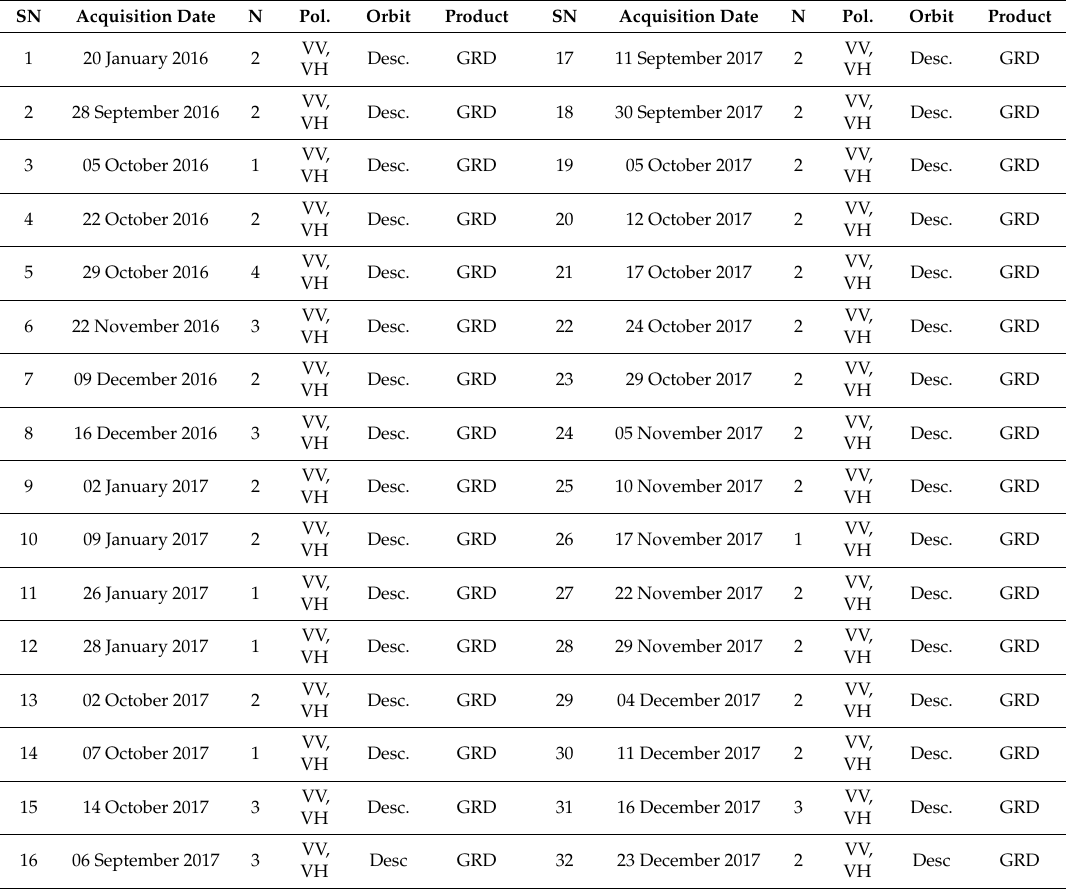
Table A1. Lists of Sentinel-1 SAR used in this